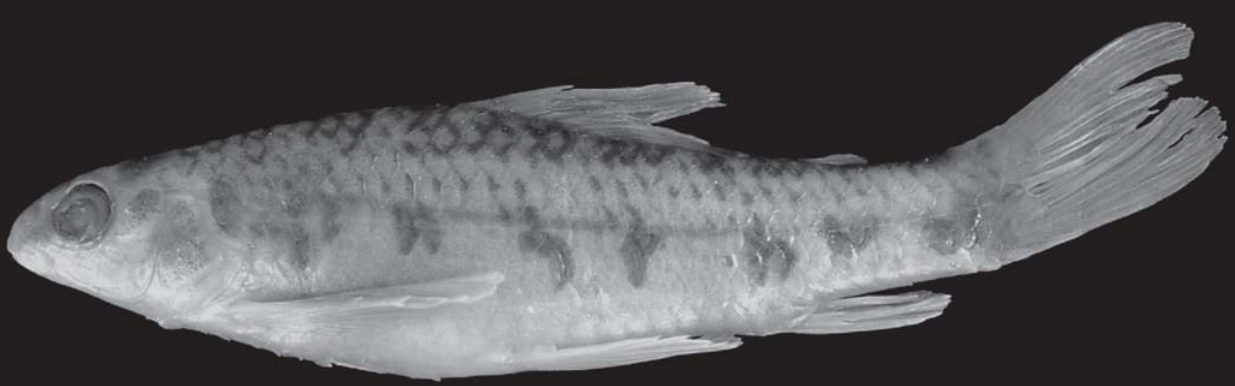
Fig. 1. Characidium heirmostigmata , holotype, MZUSP 97738, 35.0 mm SL. Picture horizontally flipped.